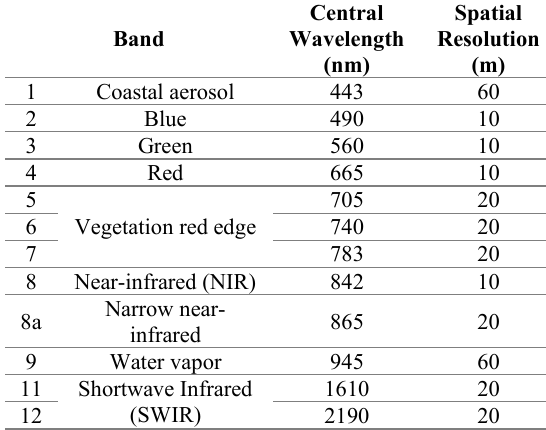
Table 3. Sentinel-2 Spectral Bands and Resolution (European Space Agency, 2015)